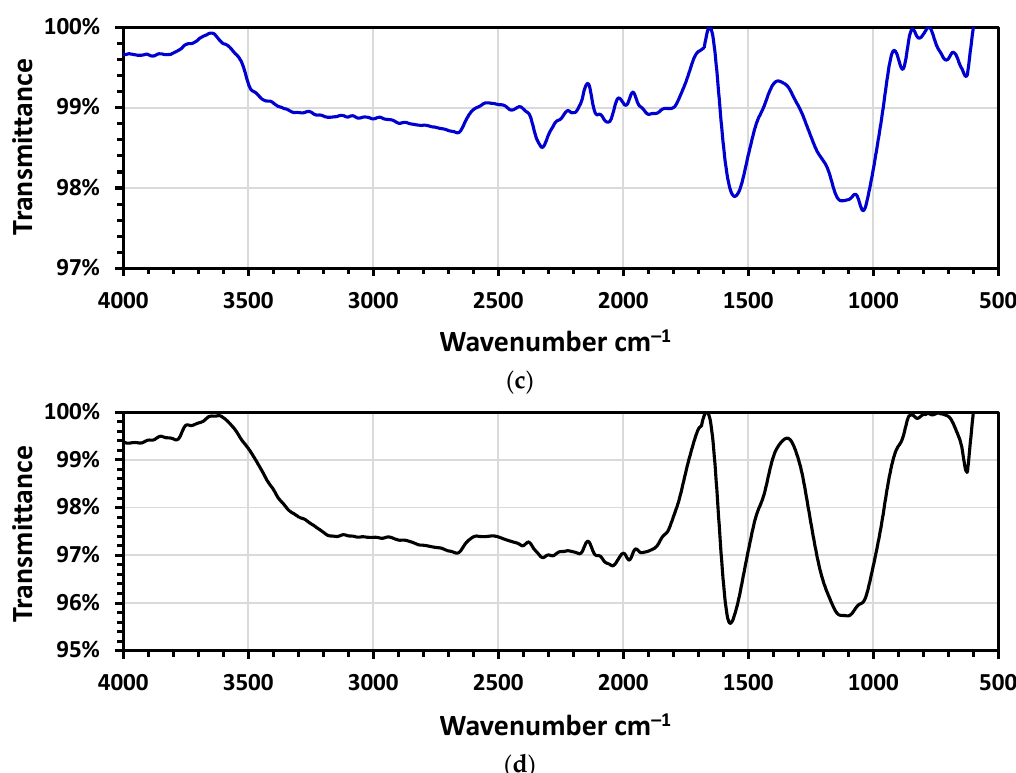
Figure 2. FTIR analysis of ( a ) raw pea pods, ( b ) raw pea pods–ZnCl 2 , ( c ) AC-ZnCl 2 /N 2 /800, ( d ) AC-ZnCl 2 /CO 2 /800 °C.